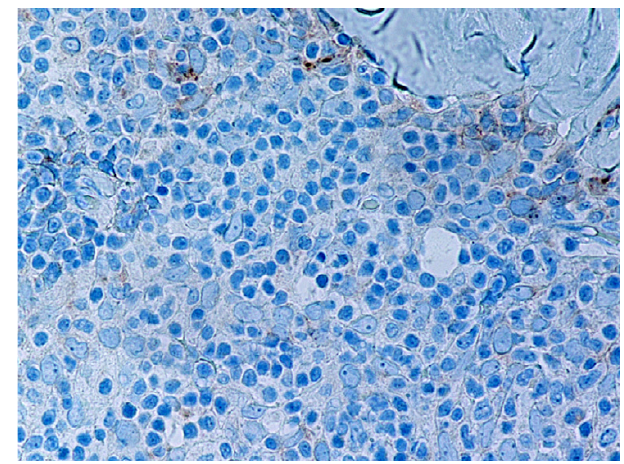
(B-SA, anti-CD20, × 200): Type B3 thymoma associated with myasthenia gravis. Intratumoral lymphocytes and single fibroblast-like cells express CD20.